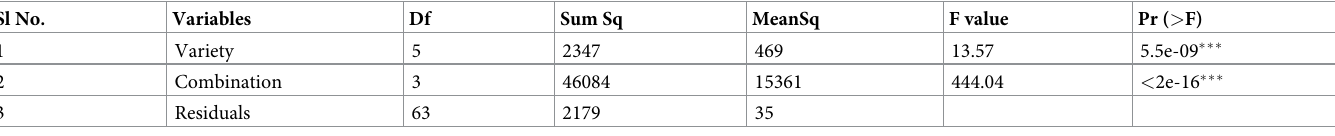
Table 9. ANOVA results for effect of proline on green shoot regeneration. Sl